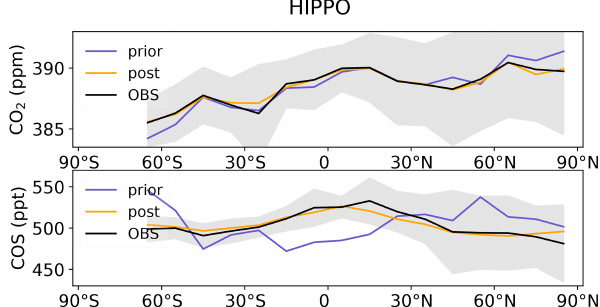
Figure 10. Comparison of the latitudinal variations in the a priori and a posteriori LMDz COS abundance with the HIPPO observa- tions. Because of the unbalanced prior, the LMDz COS abundances have been vertically shifted such that the means of the a priori are the same as the mean of the HIPPO data (521ppt). The error bar is calculated as the standard variation in the COS concentration aver- aged over longitudes and